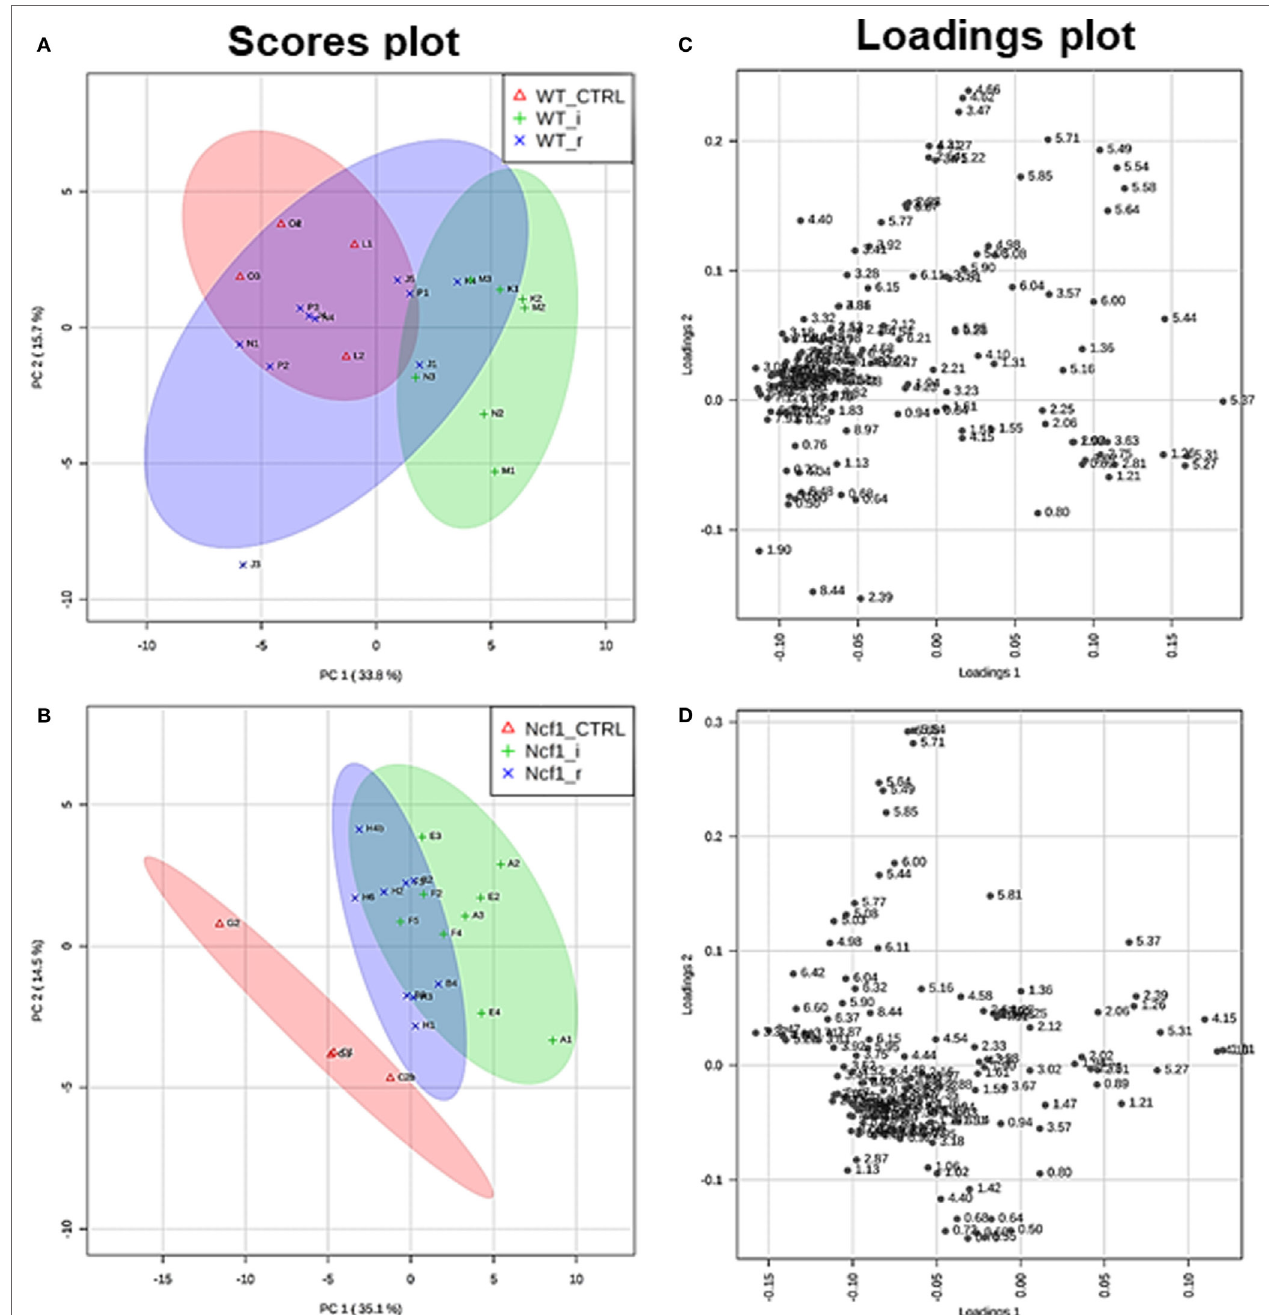
FigUre 7 | The presence of the Ncf1-mutant (Ncf1) mutation leads to distinct metabolomic profiles in mice either recovering from (r) or after a second period of DSS-induced colitis (i). This contrasts with wild-type (WT) mice which present overlapping metabolomic profiles between control, recovery, and second colitis- induced groups. Principal component analysis of 1 H spectra of WT and Ncf1mice. The scores plot for the WT reaches 49.4% of the total variance (PC1 = 33.8%, PC2 = 15.6%) (a) ; for the Ncf1 achieves 49.6% of the total variance (PC1 = 35.1%, PC2 = 14.5%) (B) . The loadings plot shows the δ of each variable (bucket) for the WT (c) and the Ncf1 (D)